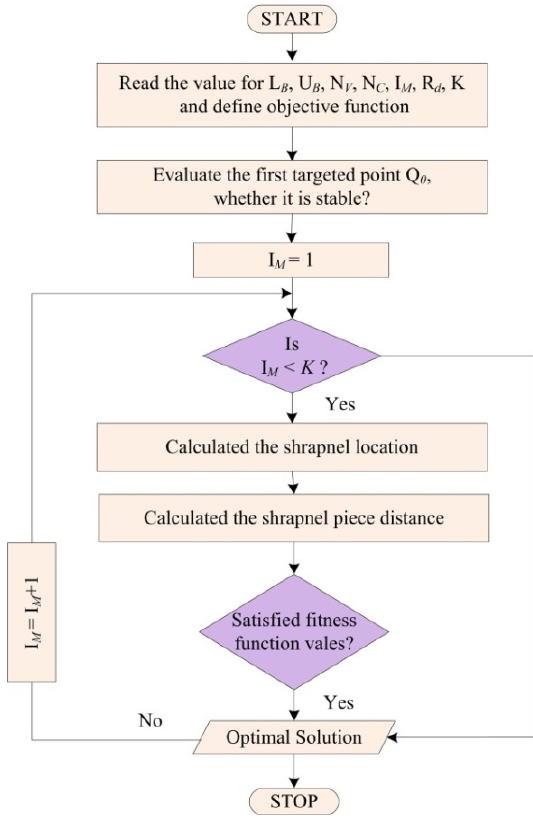
Figure 4. Flow diagram of MBA.